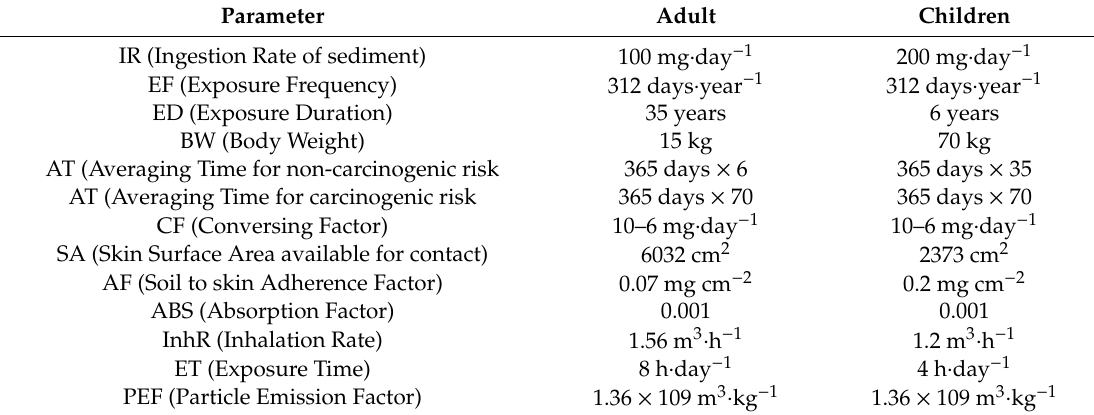
Table 1. Values adopted for the parameters used in the determination of Chronic Daily Intake (CDI) based on USEPA